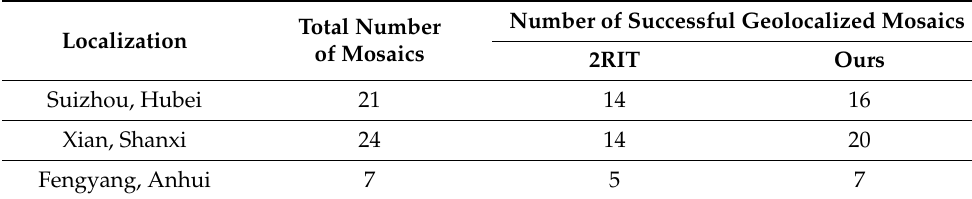
Table 3. Geolocalization result on the real flight aerial image data